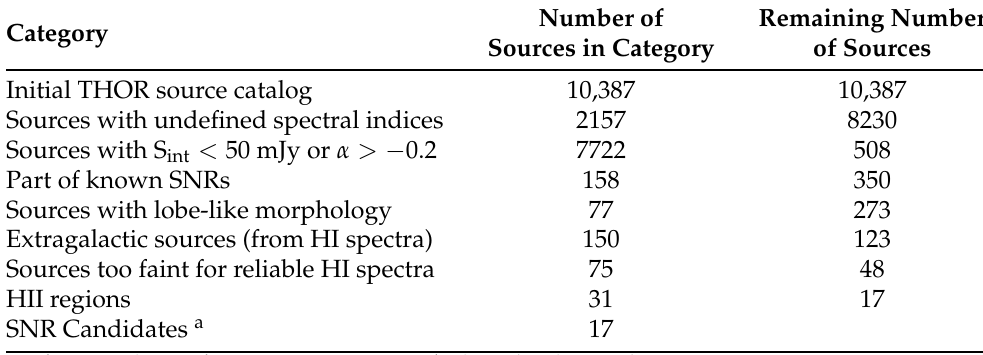
Table 1. Source numbers by